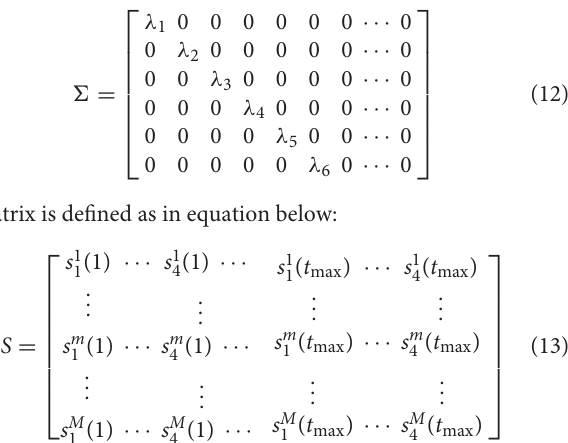
columns and S is a 600-by-600 matrix with orthogonal rows. The diagonal matrix 6 is of 6-by-600 and the diagonal elements of 6 correspond to the singular values ( λ i ) of W .